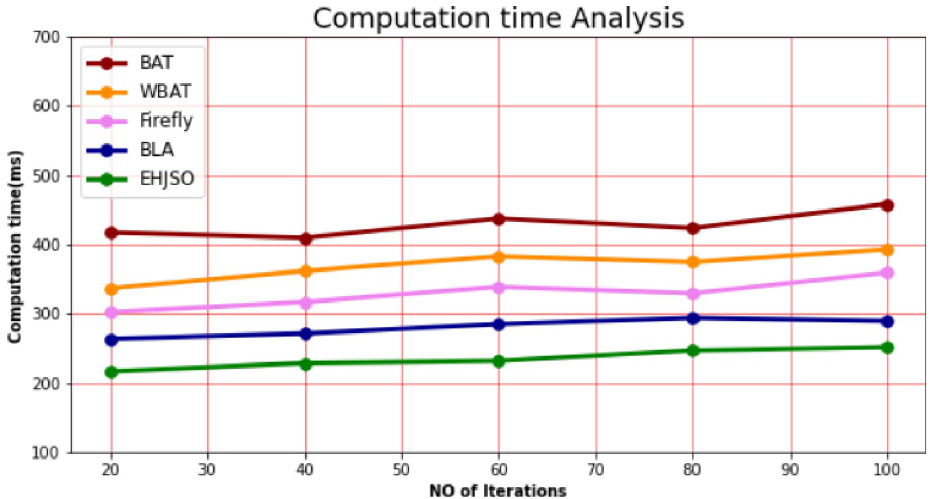
Fig 5. Computation time analysis for EHJSO method with existing system.